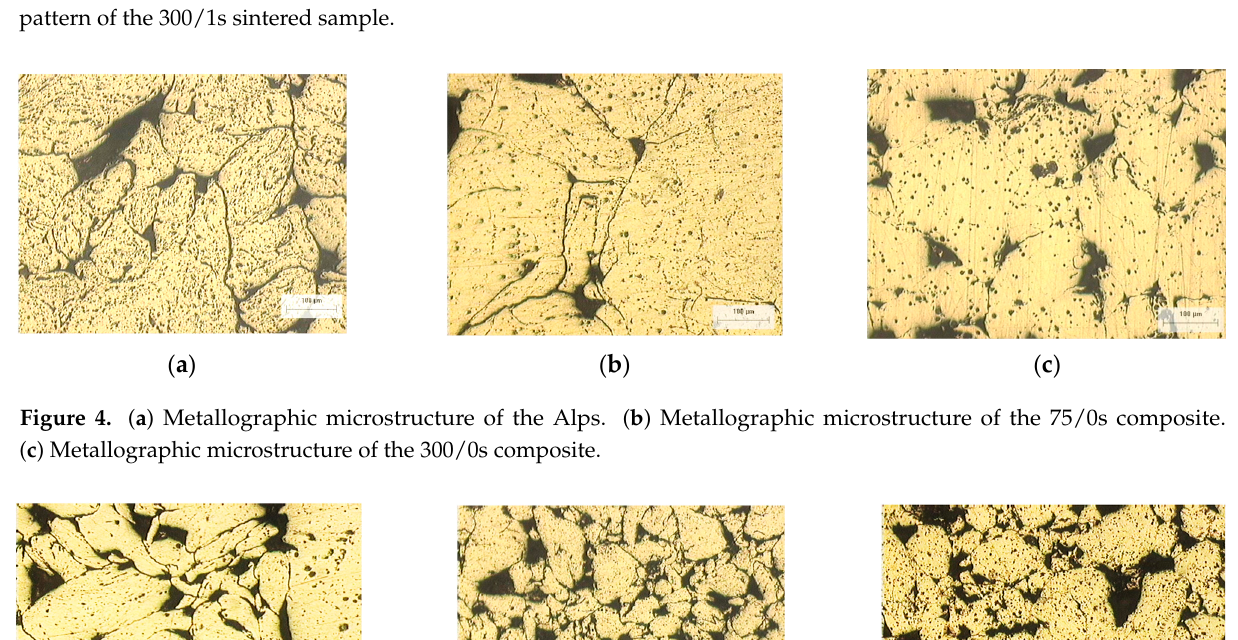
Figure 4. ( a ) Metallographic microstructure of the Alps. ( b ) Metallographic microstructure of the 75/0s composite. ( c ) Metallographic microstructure of the 300/0s composite.